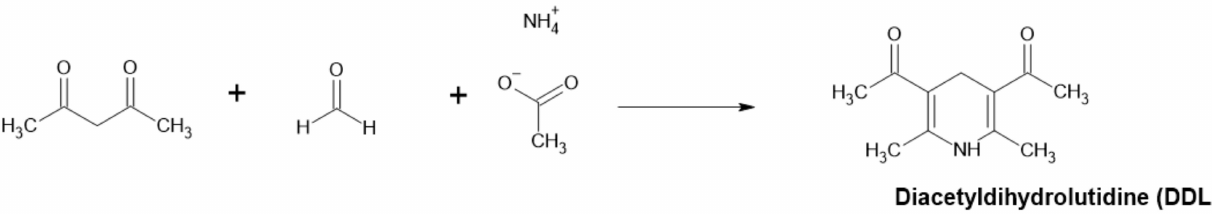
Figure 12. Detection of aldehyde by acetylacetone and ammonium